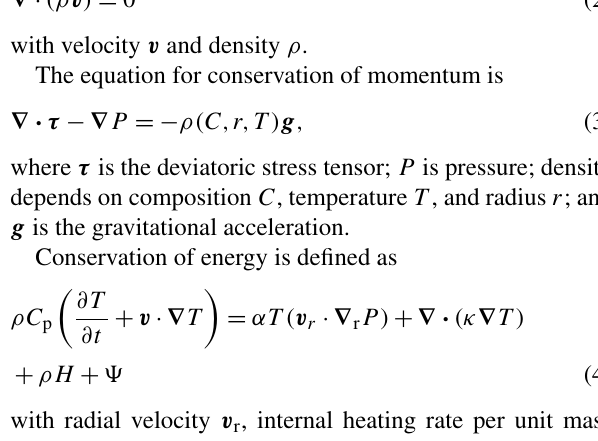
Table 2. List of tested parameters. Parameter Symbol Value Units Primordial layer Surface density: primordial ρ prim Model parameter Yield stress τ y Yield stress